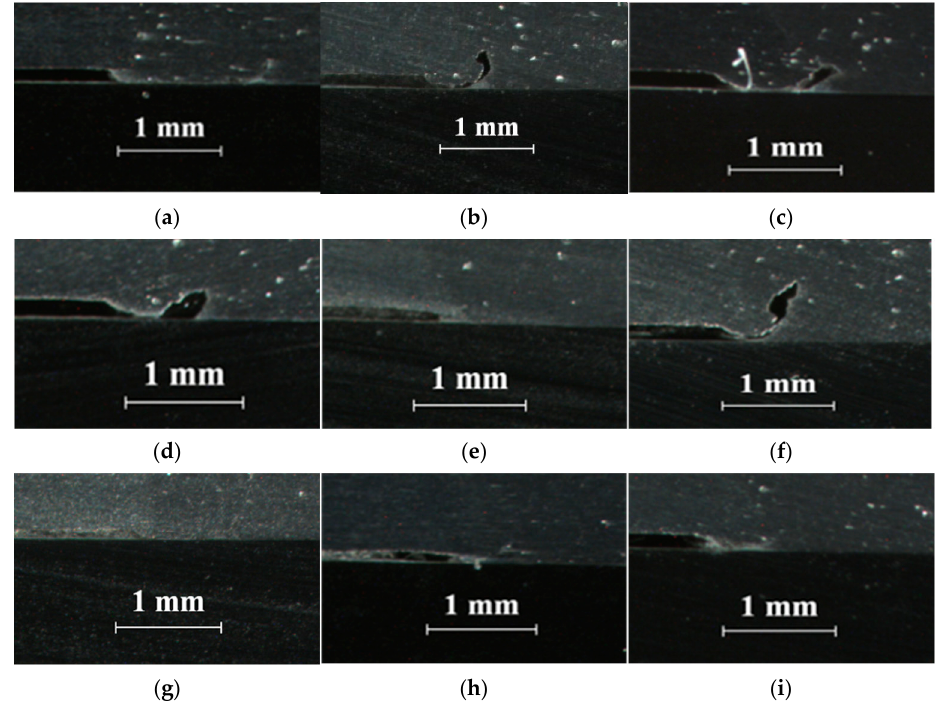
Figure 3. Feature of defect in root area of dissimilar braze-welded joints: ( a ) 50 A, 0%; ( b ) 60 A, 0%; ( c ) 70 A, 0%; ( d ) 50 A, 10%; ( e ) 60 A, 10%; ( f ) 70 A, 10%; ( g ) 50 A, 20%; ( h ) 60 A, 20%; ( i ) 70 A, 20%.